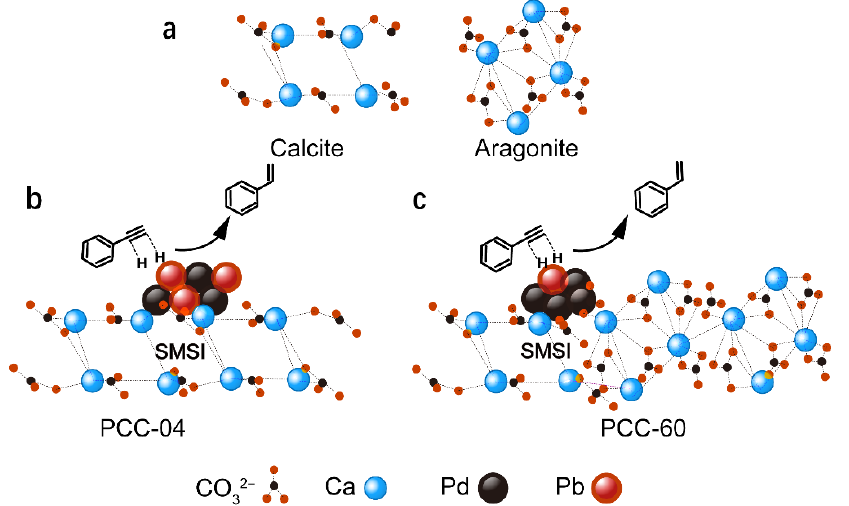
Figure 5. Simplified illustration of our PCC-derived catalysts’ working hypothesis: ( a ) crystal model diagram of calcite and aragonite. A model reaction diagram of the semi-hydrogenation of phenylacetylene over ( b ) PCC-04 (i.e., consists of calcite phase only) and ( c ) PCC-60 (i.e., contains both calcite and aragonite phases) support. Only the calcite phase is catalytically relevant and delivers a strong metal-support interaction (SMSI), which allowed uniform distribution of Pd/Pb, presumably through complexation, key criteria to provide the “active-site isolation”, a feature necessary for the catalysis presented in this study.